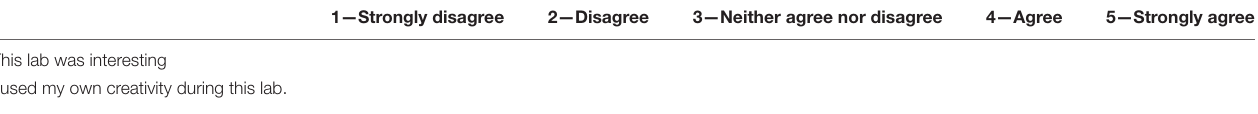
TABLE 2 | After each introductory and CURE lab, students completed the engagement survey below anonymously.